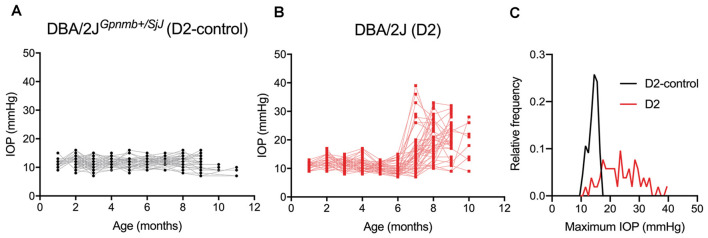
Eye pressure is elevated in DBA/2J mice. (A,B) Intraocular pressure (IOP) measurements from DBA/2JGpnmb+/SjJ (D2-control, A) mice (n = 62 eyes from 31 mice) and DBA/2J (D2, B) mice (n = 66 eyes from 33 mice). (C) Histogram of peak IOP values obtained from D2 and D2-control mice. D2-control IOPs were narrowly distributed (median = 14 mmHg) while the peak IOPs from D2 mice showed a broader distribution (median = 23 mmHg).